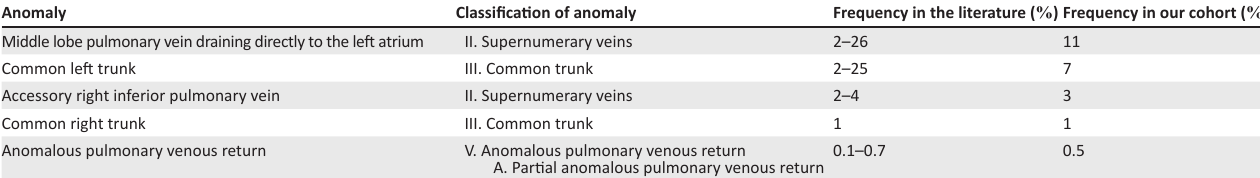
TABLE 1: The commonest pulmonary vein anomalies. Anomaly Classification of anomaly